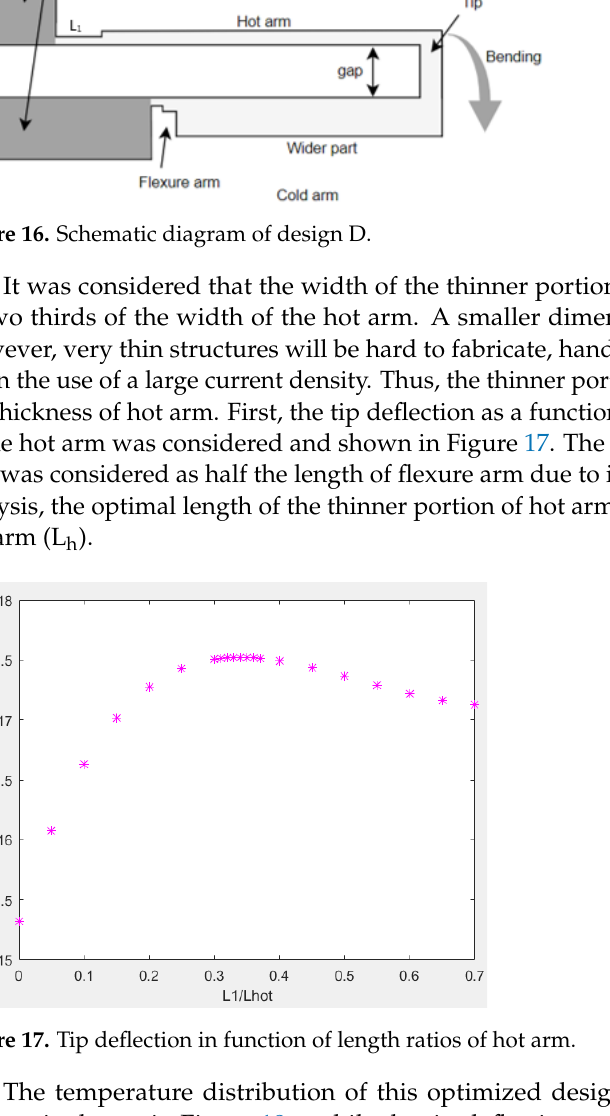
( b ) Figure 18. Performance of design D actuator compared to other designs: ( a ) temperature distribu- tion; ( b ) tip deflection. 4. Optimized Actuator-Cantilever Setup From the analysis performed above, design D allowed a higher temperature differ- ence between the hot and cold arm structures. Consequently, there was a higher bending of the tip in that case. The main purpose of this analysis was to obtain a higher cantilever excitation in the horizontal direction allowing the smaller axis of the ellipse described by the fiber tip to come close to a circle. There were a few samples prepared having the bridge shapes like that of a design D MEMS electrothermal actuator. A cantilever fiber was placed at the uplifted bridge to- wards the hot arm as in schematics of Figure 2. In addition, a small portion of the 12 μ m fiber was attached to the second half of the distal end of the cantilever, towards the colder arm side with an epoxy. The main purpose to add a smaller fiber portion to one side of the fiber was to cause asymmetry to the vibrating fiber separating the resonant frequencies